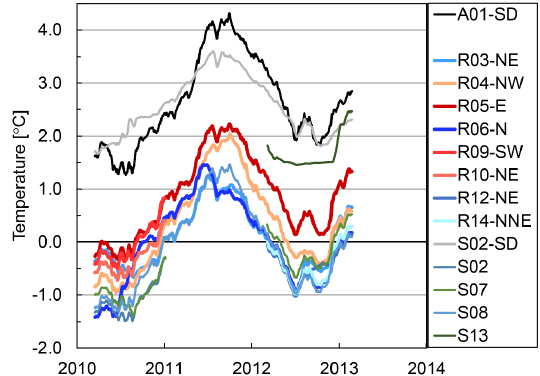
Figure 5. Mean annual rock and soil surface temperatures (all except A01-SD) and air temperature (A01-SD) during the period September 2009 to August 2013 shown as simple moving 365-days average for all sites. To ensure that the temperature variability was not shifted in time, the mean values were centred (an equal number of days on either side of the mean value). A01-SD is air temperature in Signaldalen (SD), R03 to R14 are the rock face loggers, and S02 to S13 are the soil temperature